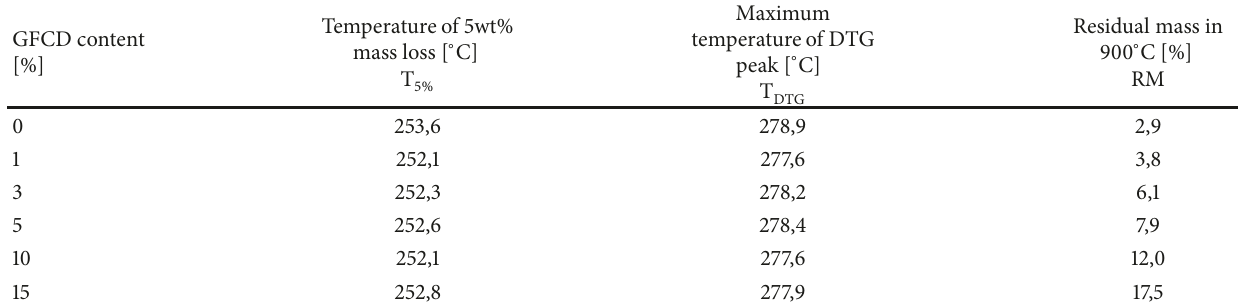
Figure 9: The relationship between the composite impact strength a Table 1: TGA results of PVC and PVC/GFCD